Question: In one sentence, what is this figure communicating?
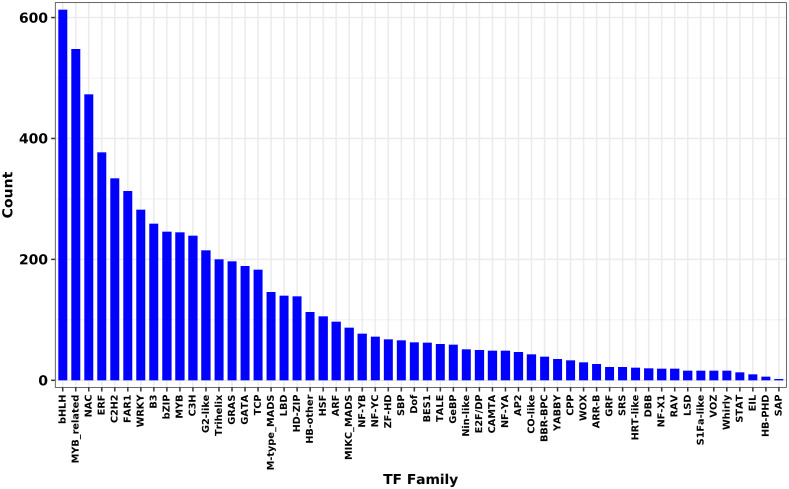
Answer: Statistical chart of TFs family. The Abscissa is the different transcription factor family, and the ordinate is the gene number of the transcription factor family.